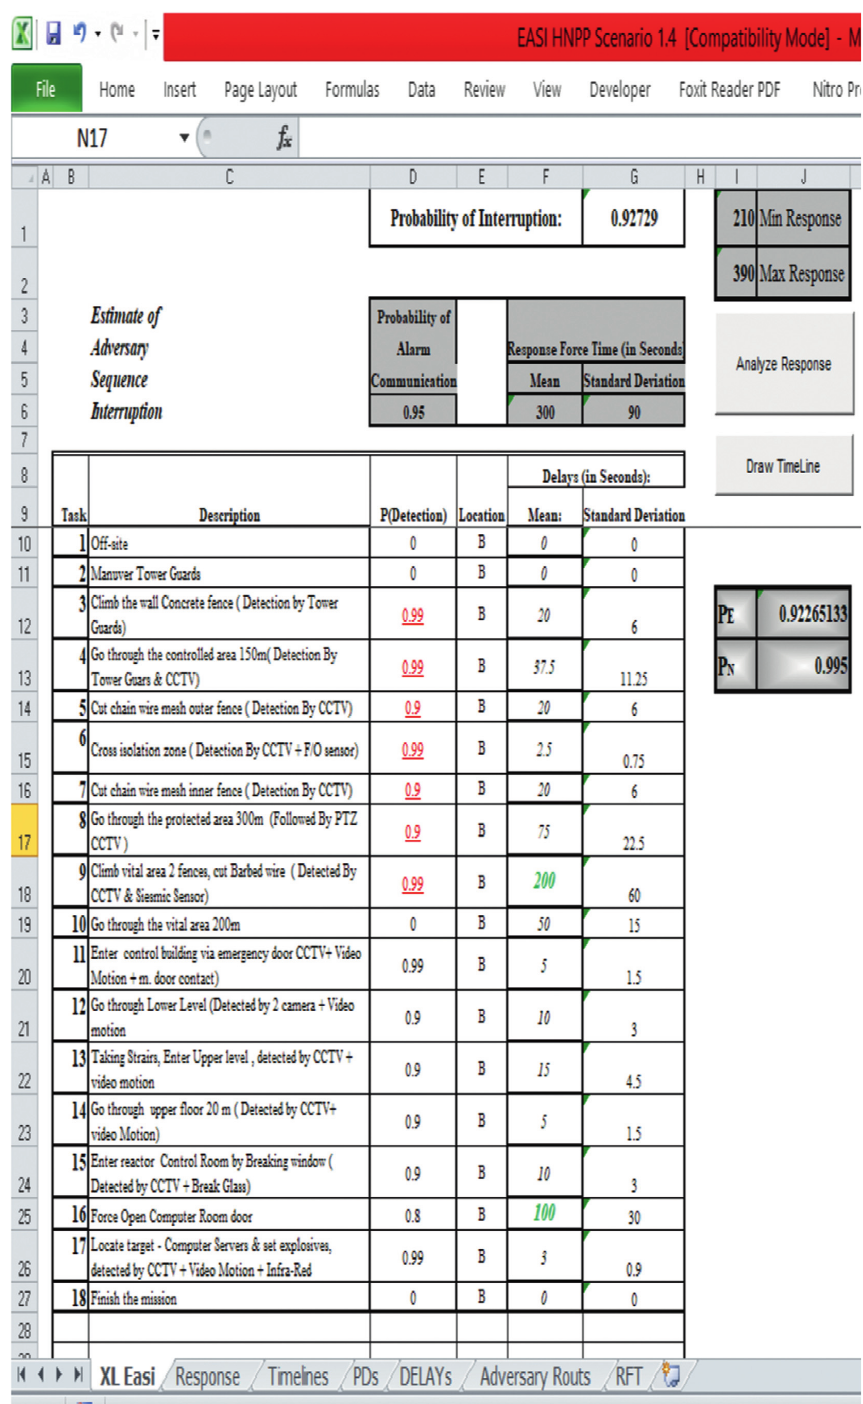
Figure 11: Attack path action sequence and EASI calculation of P